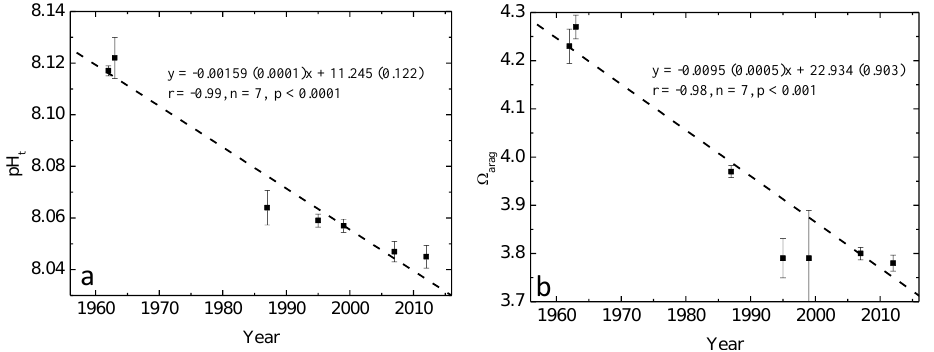
Figure 6. Temporal changes in sea surface pH (in the total hydrogen scale, pH t ) (a) and aragonite saturation state ( (cid:127) arag ) (b) . pH t and (cid:127) arag were calculated from p CO 2 and TA as described in Sect. 2.4. All data are corrected to the same month (April).